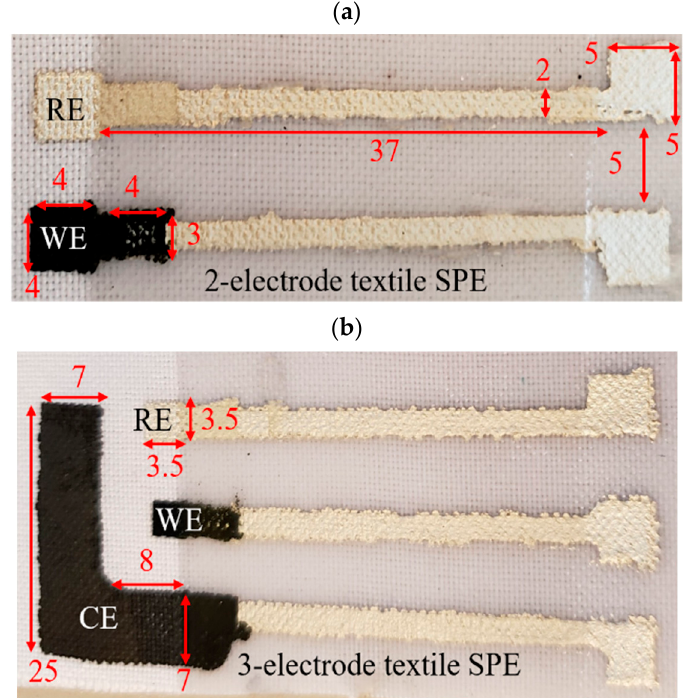
Figure 3. SPE sensor designs showing lateral dimensions in millimeters: ( a ) 2-electrode design; ( b ) 3-electrode design ( a ) adapted from [23]).